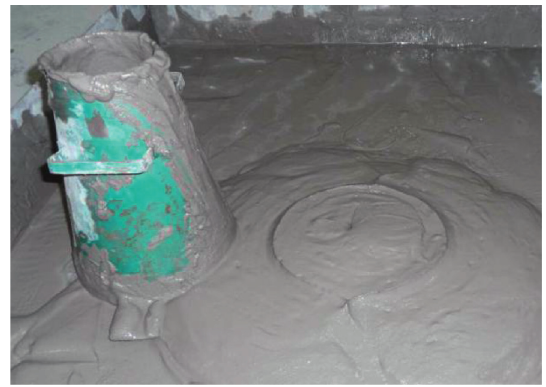
Figure 3: Slump test of slurry.